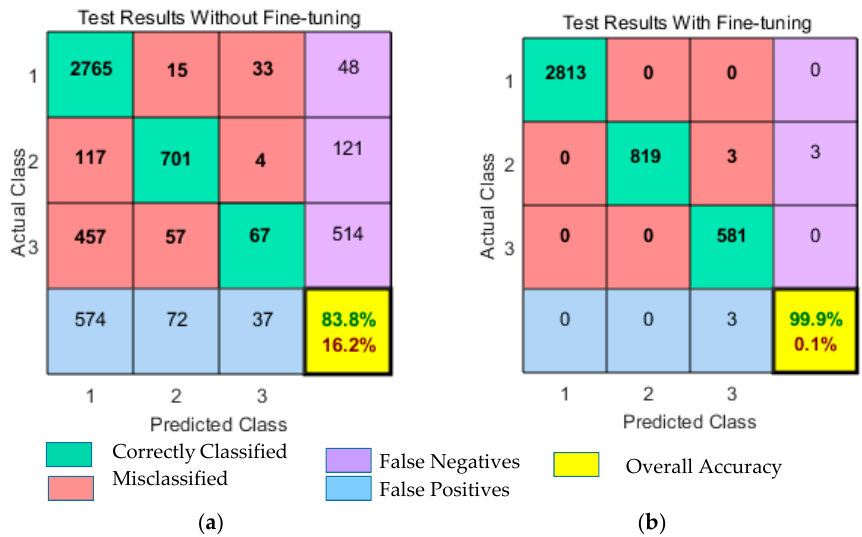
Figure 11. Performance of fine-tuning strategy is displayed with confusion matrix: ( a ) Results without fine-tuning; ( b ) Results with the fine-tuning approach.